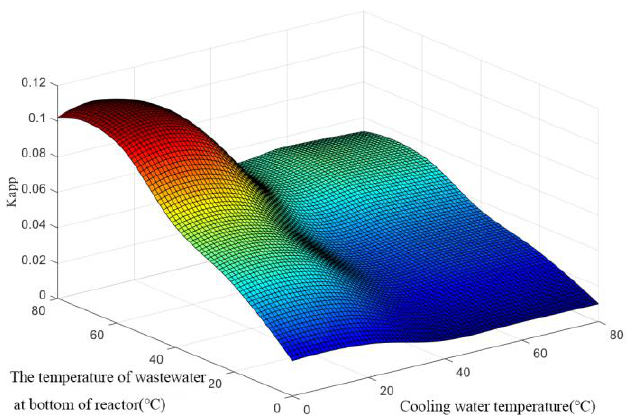
Figure 7. The numerical fit of first-order rate constants versus LED arrays and wastewater temper-